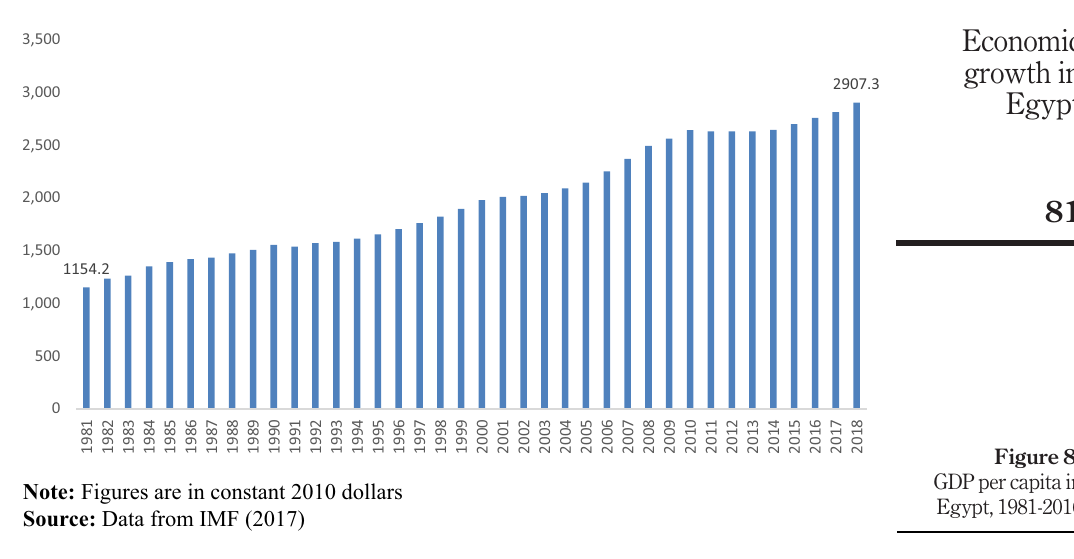
Figure 8. GDP per capita